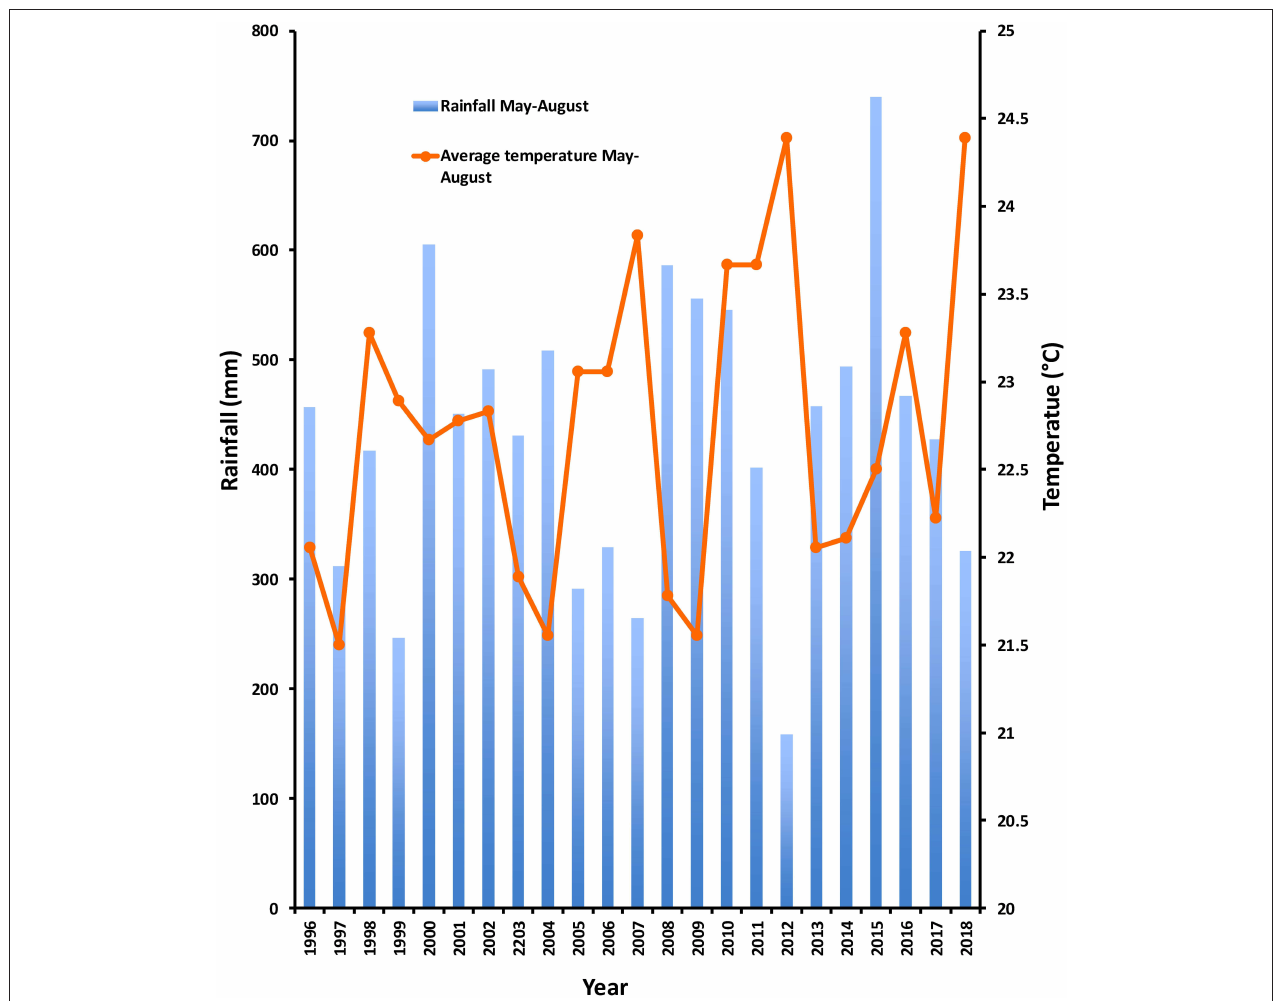
FIGURE 4 | Total rainfall and mean daily temperature for the months May-August over the years 1996–2018 for the Troy, MO, weather station (https://www.ncei.noaa. gov), the closest weather station to Cuivre River State Park ( ∼